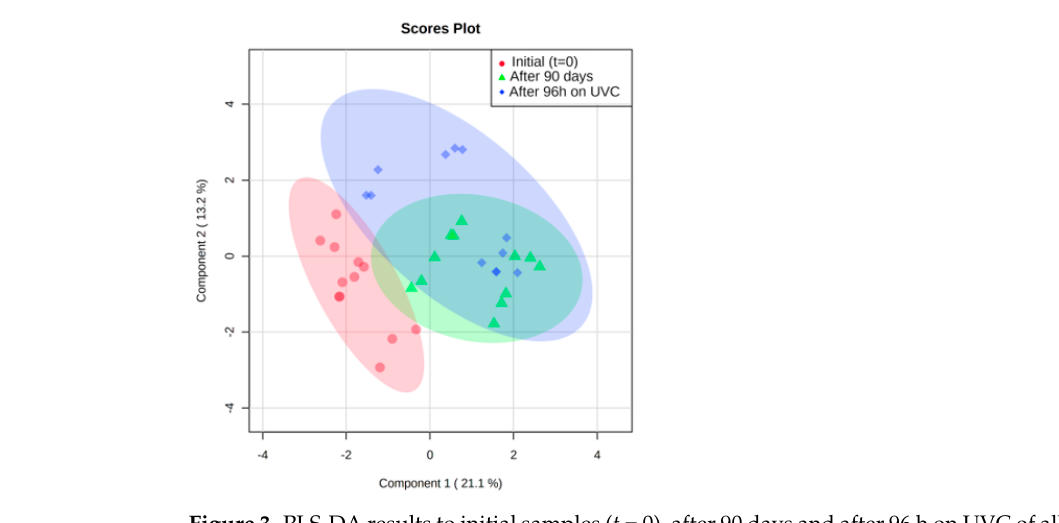
Figure 3. PLS-DA results to initial samples ( t = 0), after 90 days and after 96 h on UVC of all geno- types: ‘IAC Alvorada’, ‘TAA Dama’, ‘BRS Estilo’ and ‘BRS Pérola’.